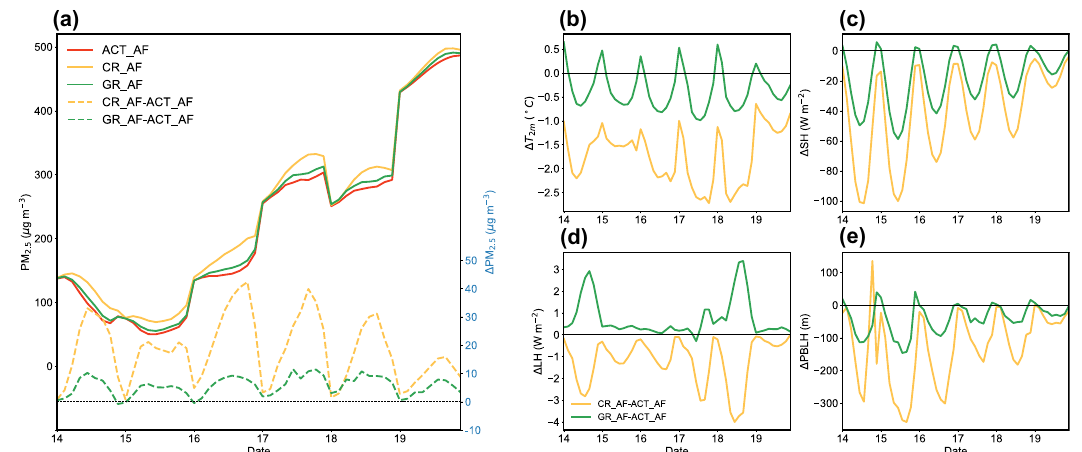
Fig. 2 Trend and variation of PM 2.5 concentration and related meteorological variables. Difference in daytime (9:00 – 17:00 LST) a near- ground PM 2.5 concentration and meteorological variables: b 2 m air temperature (T 2m ), c sensible heat (SH), d latent heat (LH) and e planet boundary layer height (PBLH) between CR_AF and ACT_AF, GR_AF and ACT_AF. The left y axis of Fig. 2a represents solid lines in the fi gure; the right y axis represents dashed